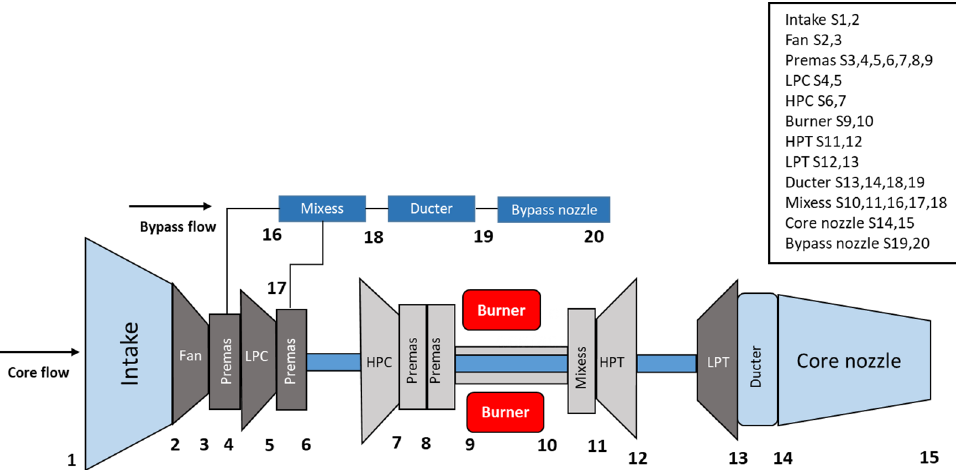
Figure 1. Research engine Turbomatch thermodynamic model showing numbered stations and component modules.